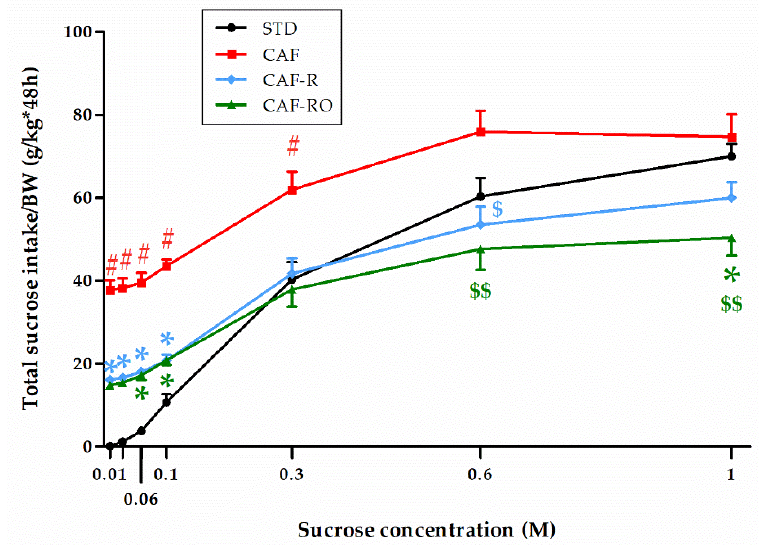
Figure 4. Effects of the dietary treatments on the total sucrose intake during the two-bottle preference test. Total sucrose intakes (g) were relativized to the body weight (BW, kg). Data are expressed as the mean ± SEM. * p < 0.05 vs. STD group; $ p < 0.05, $$ p < 0.01 vs. CAF group; # p < 0.05 vs. all groups.